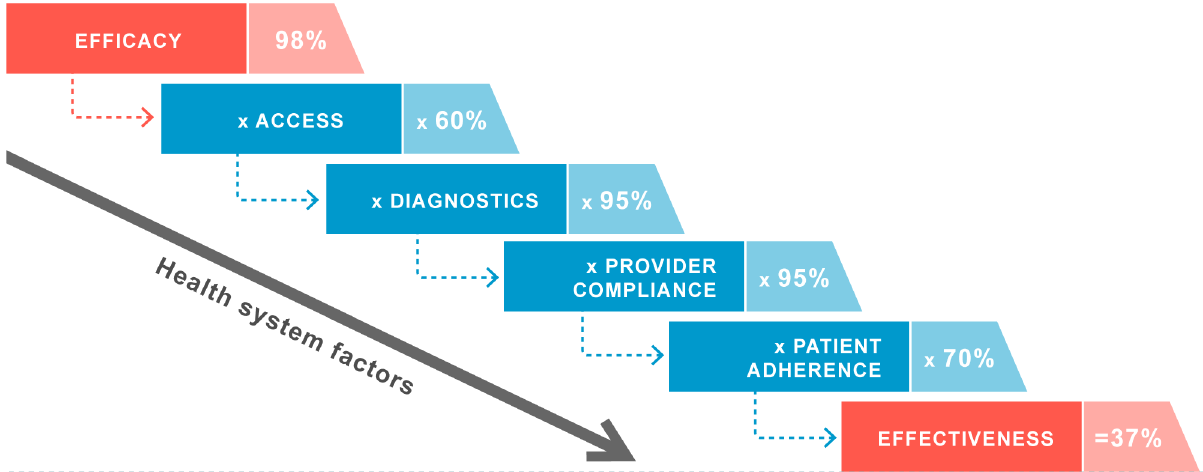
Fig 2. Effectiveness decay. Loss of effectiveness of interventions within the health system is depictedhere by steps. The pattern of effectivenessdecay (how much is lost and at what step) varies and dependson the specifics of a given health system [12]. The percentages of decay/lossare